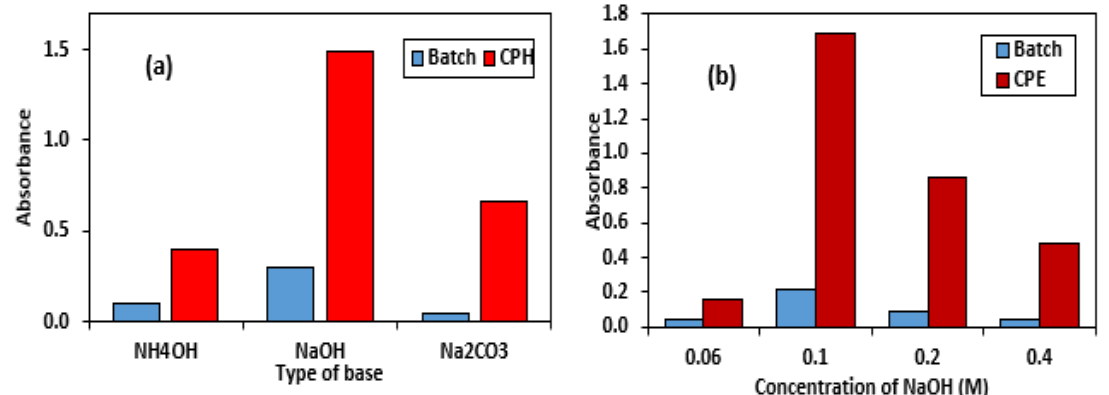
Figure. 5. (a) Effect of type of base, (b) Influence of the concentration of sodium hydroxide solution